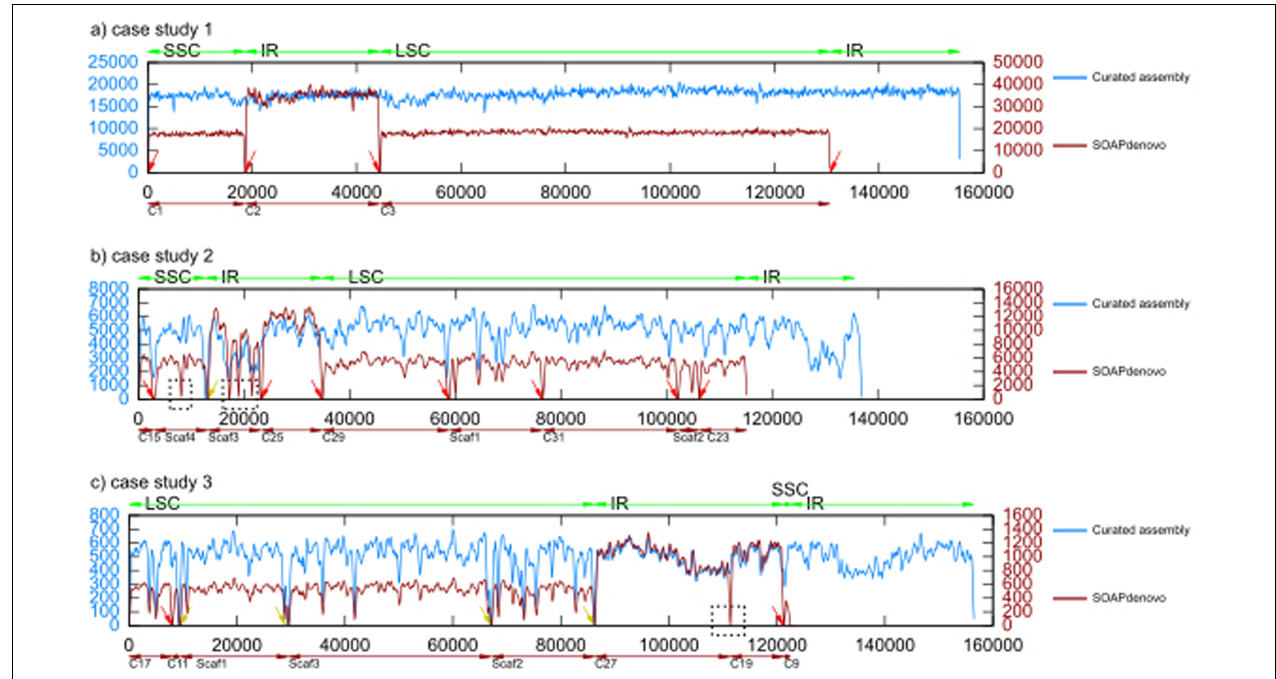
FIGURE 4 | Comparison of read coverage between the assembly from SOAPdenovo and the curated assembly.